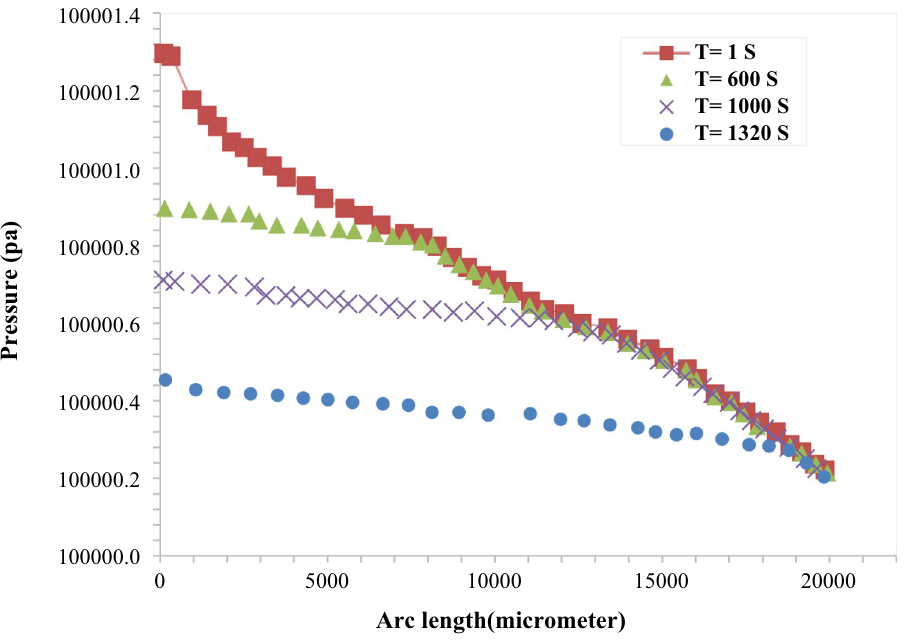
Figure 14. Pressure profile for water flooding at various time